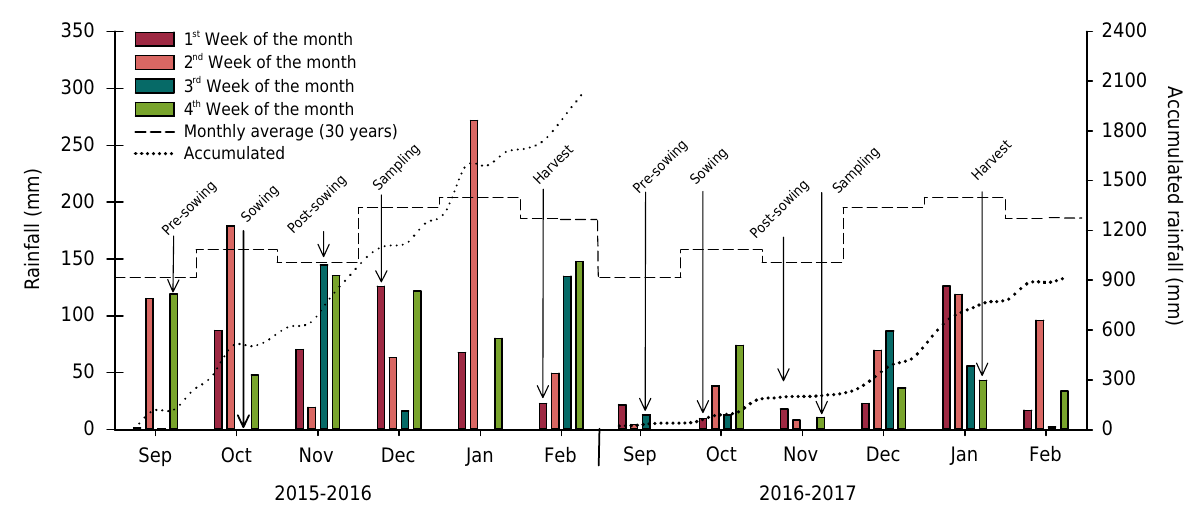
Figure 1. Weekly and accumulated rainfall during the experimental period for the crops in 2015/2016 and 2016/2017. Monthly average rainfall was considered the period between 1986 to